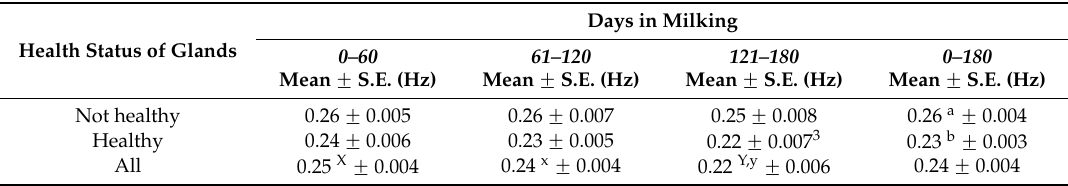
Table 9. Overall means and standard errors (S.E.) of the bandwidth length, according to mammary gland health status and lactation stages.